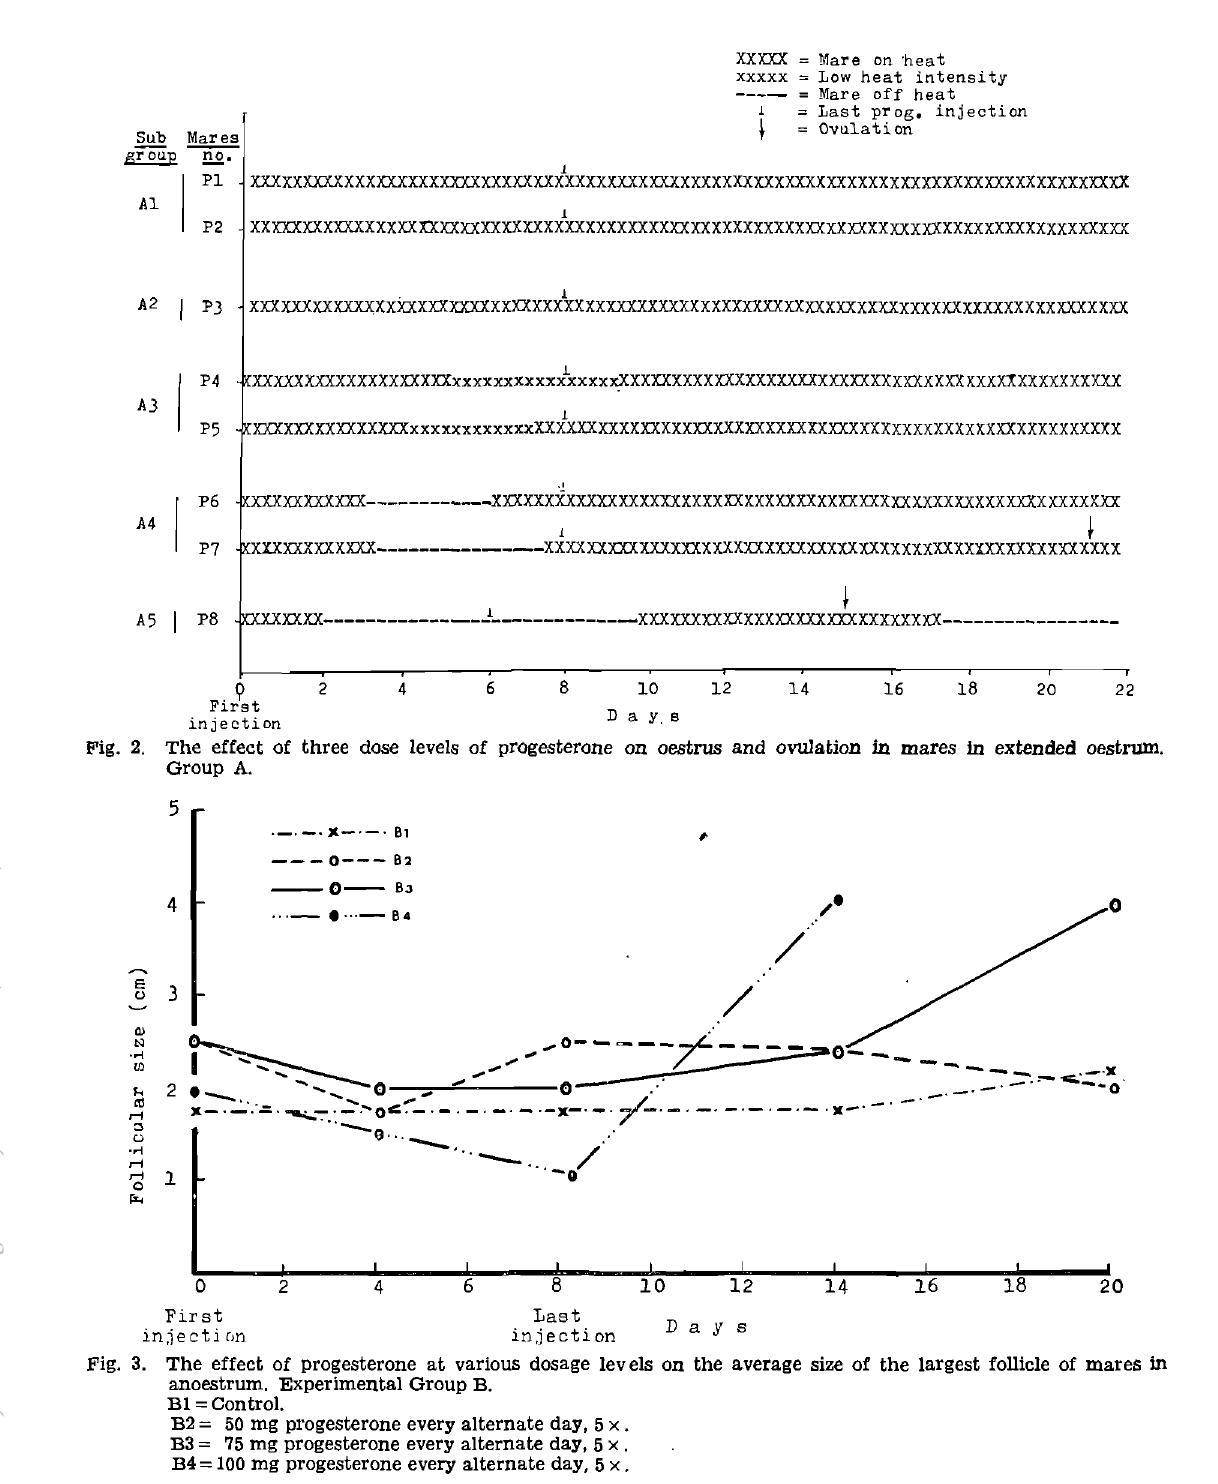
Fig. 2. The effect of three dose levels of progesterone on oestrus and ovulation in mares in extended oestrum. Group A.